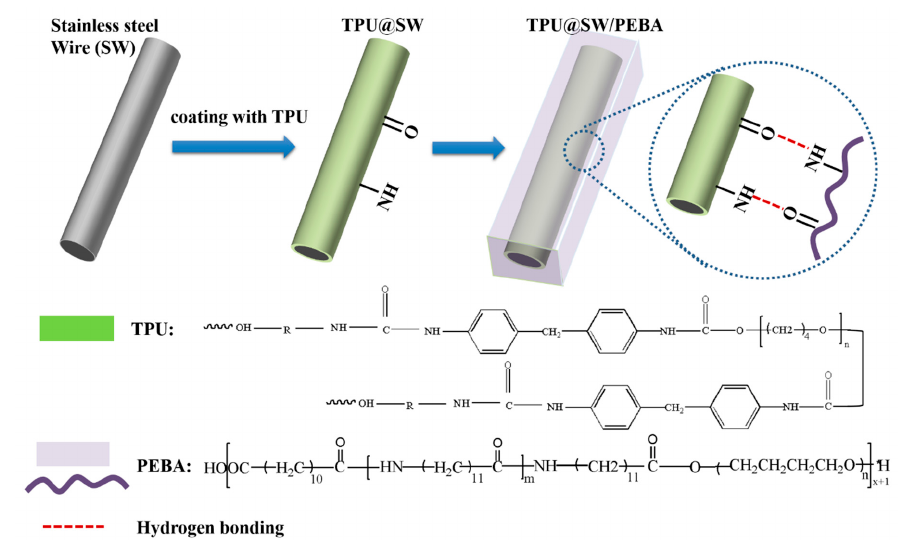
Figure 5. Interlaminar shear strength of composite before and after coating.